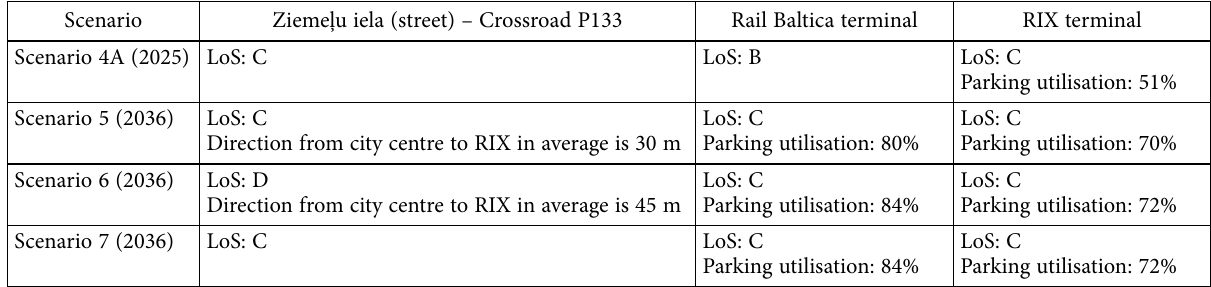
Table 3. Simulation results